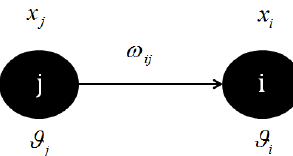
Figure 2. Structure of the multilayer feed-forward neural network (MLFN).